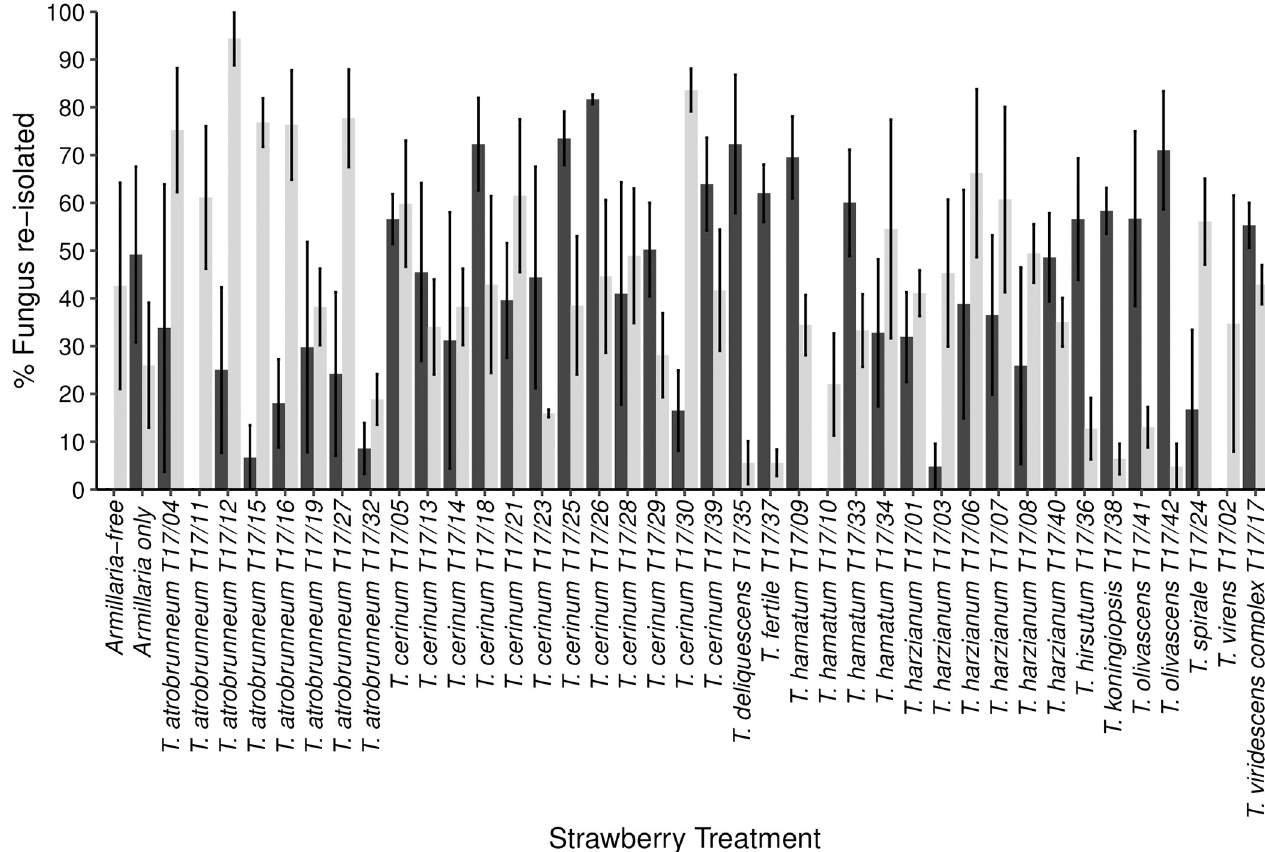
Fig 2. Re-isolation (percentage) of Armillaria mellea (black) and Trichoderma spp. (grey) from strawberry roots three months post inoculation with A . mellea